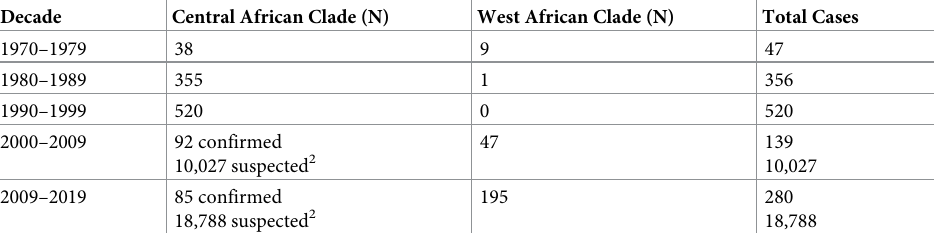
Table 2. Number of Cases per Clade 1